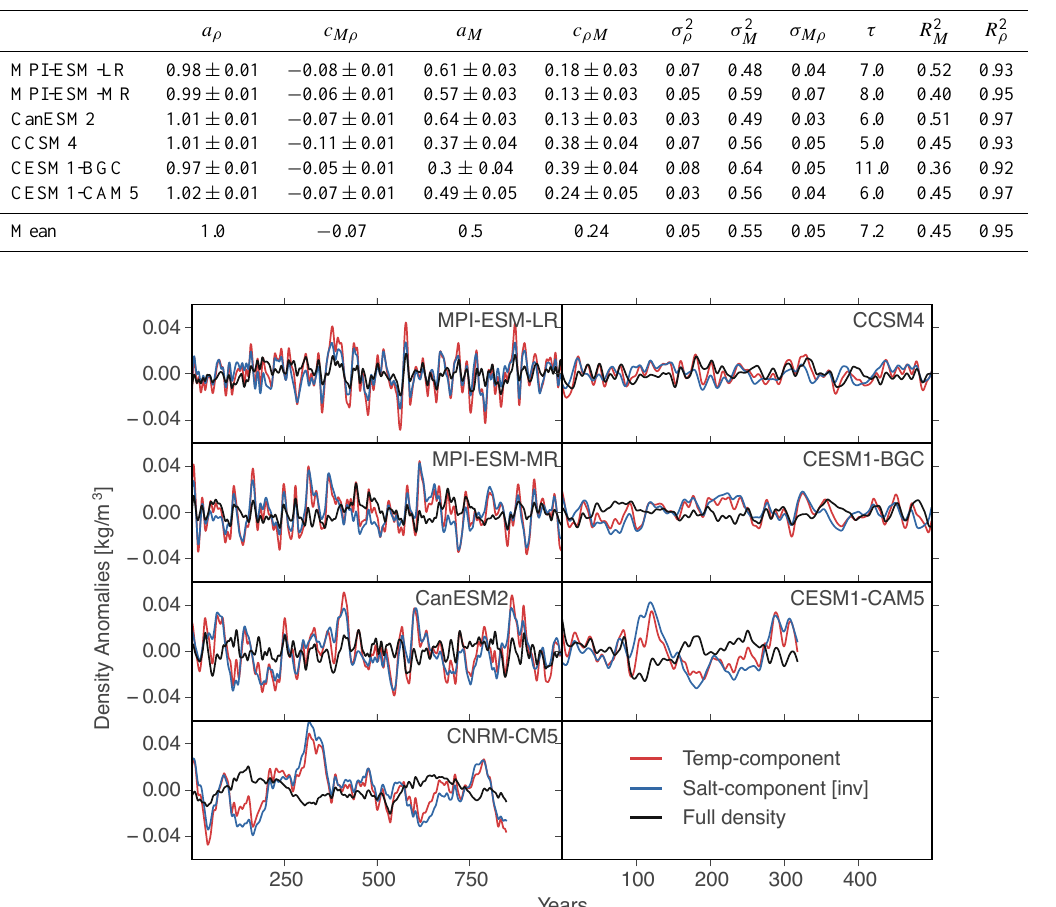
Fig. 7. North Atlantic Deep Ocean density time series (black) and its salinity (blue, inverted) and temperature (red) related components.